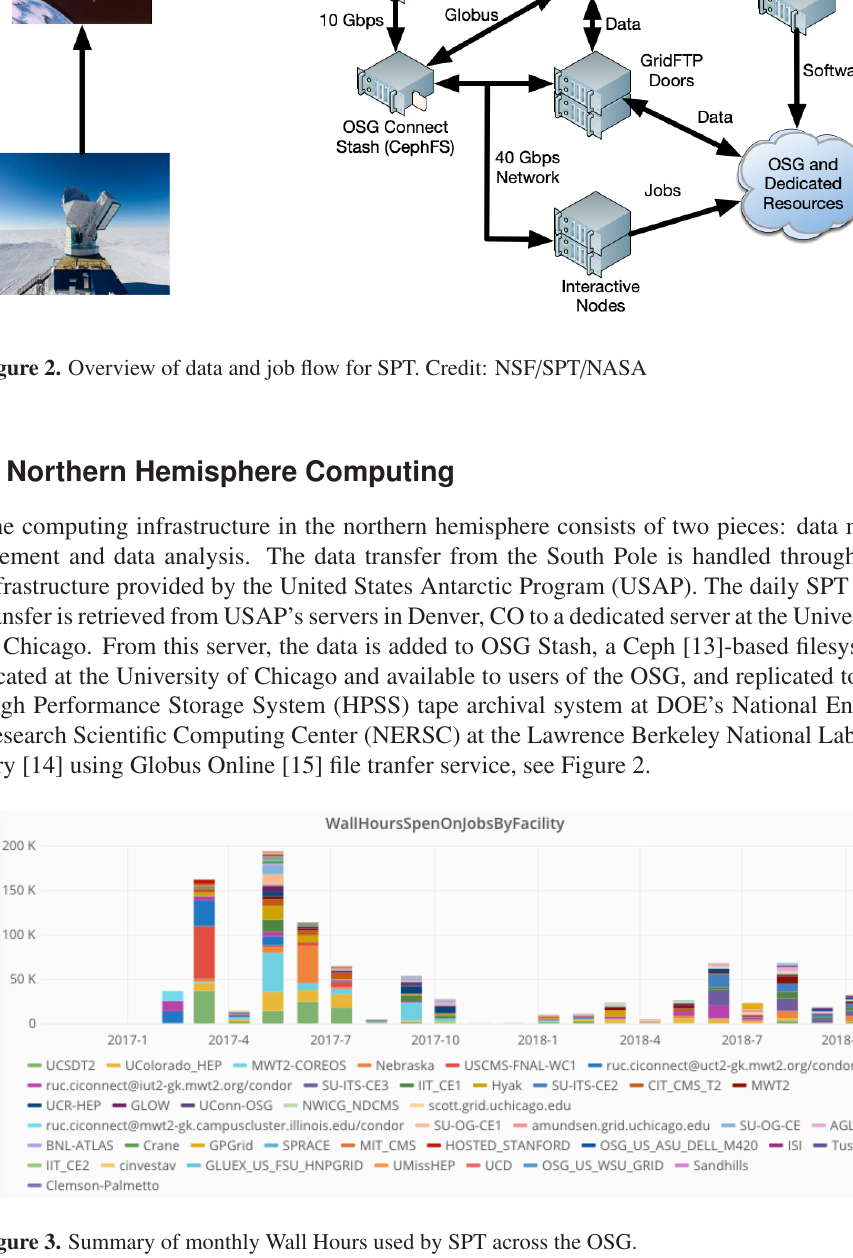
Figure 3. Summary of monthly Wall Hours used by SPT across the